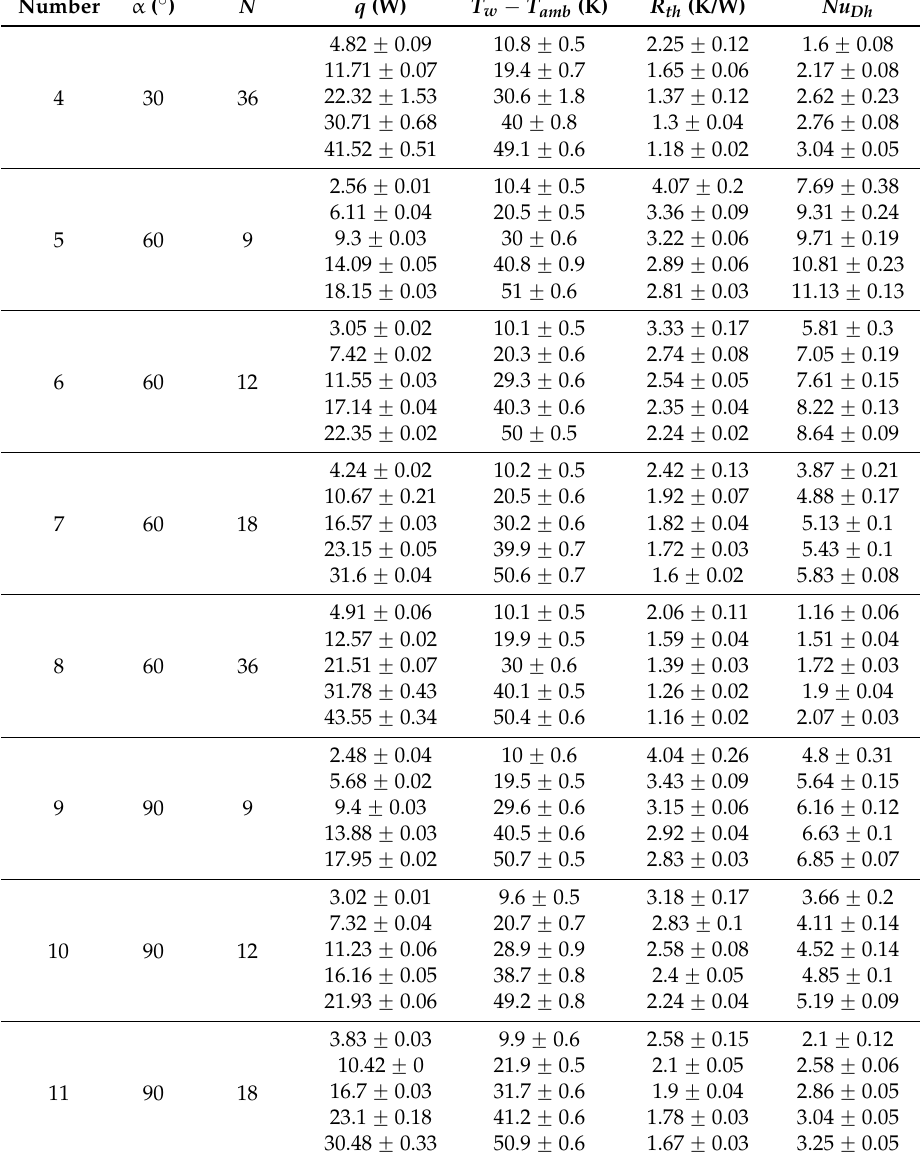
resistances measured from the inclined plate fin heat sink ( α = 60 ˝ , N = 36) in the present study are compared with those from the radial plate fin heat sink ( N = 36) in [15]. Figure 5 shows that the inclined plate fin heat sink has thermal resistances up to 10% lower than those of the radial plate fin heat